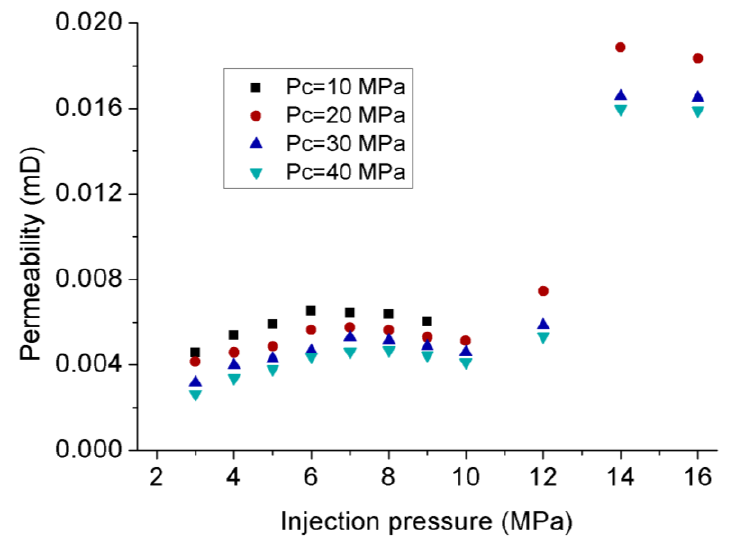
Figure 11. Relationship between permeability of siltstone under different injection pressures (traditional method). (traditional